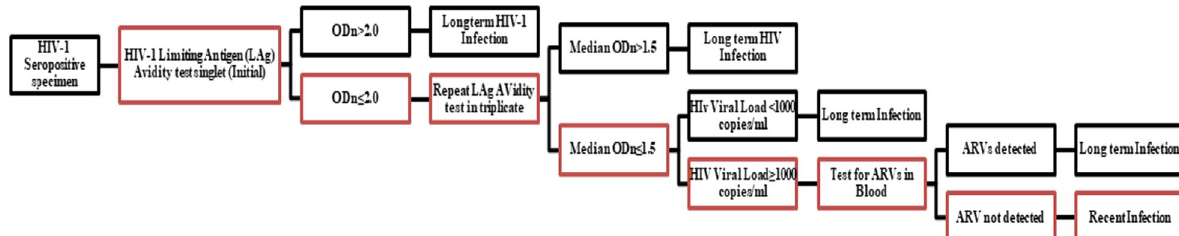
Fig. 1 HIV-1 recent infection testing algorithm (LAg/VL/ARV